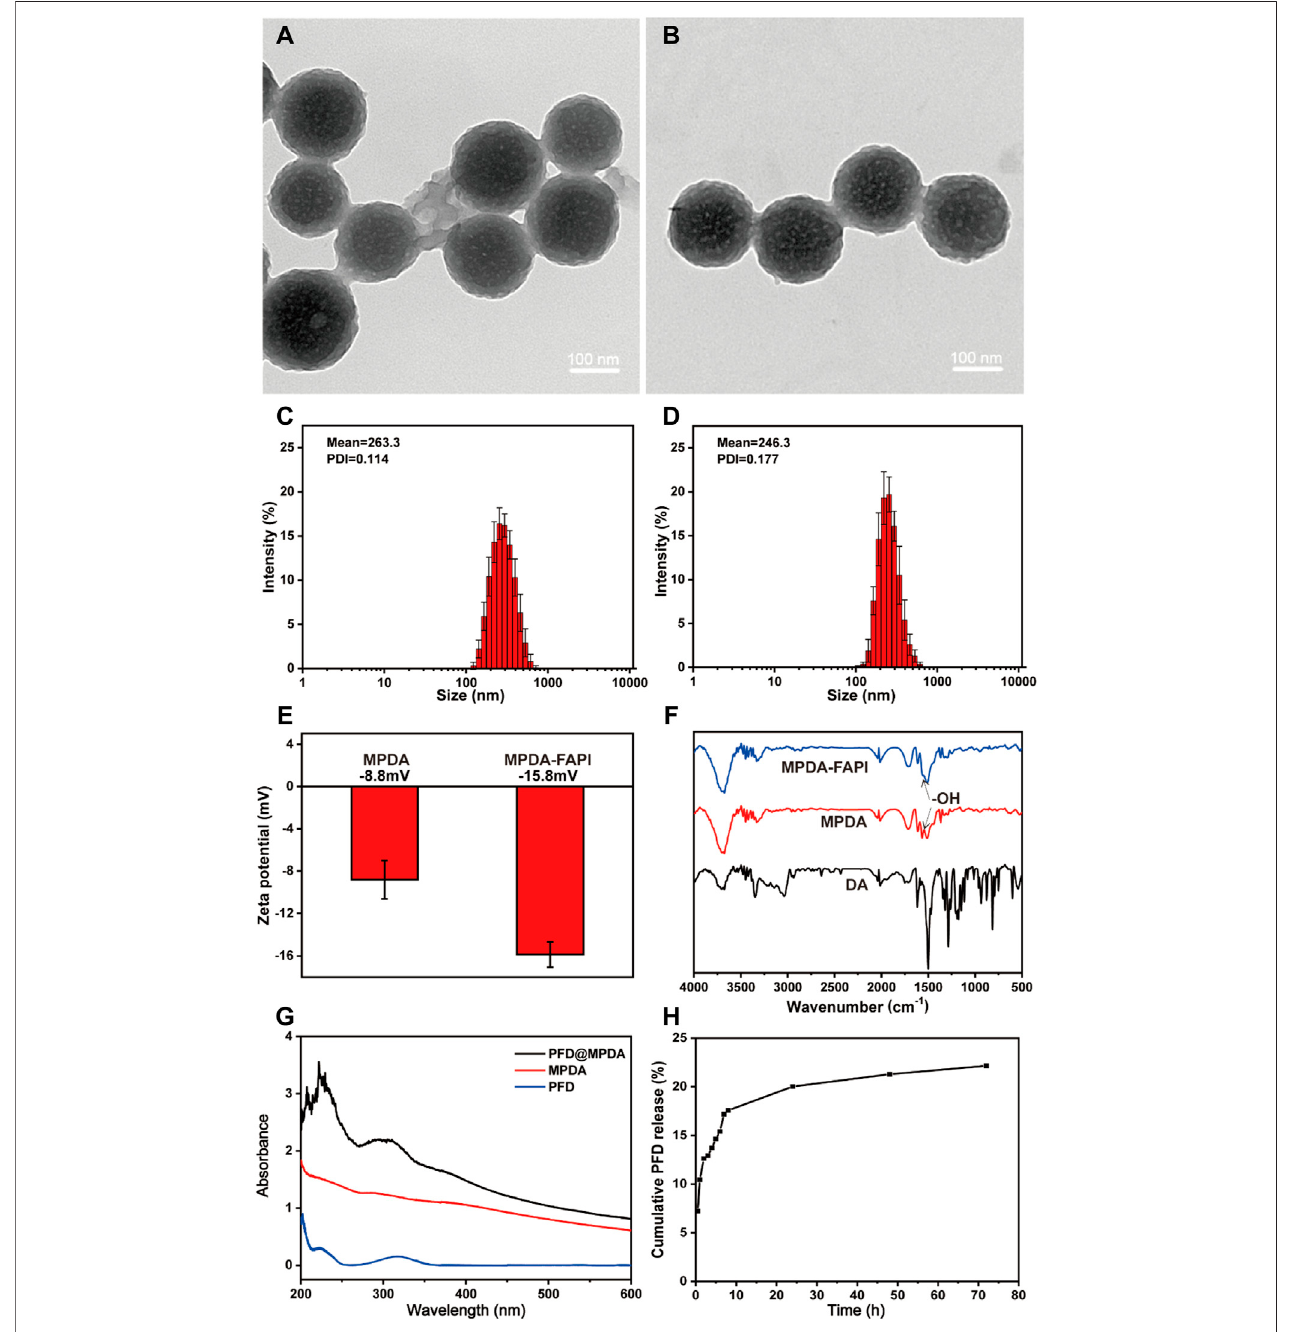
FIGURE 1 | TEM images of (A) MPDA and (B) MPDA-FAPI. Hydrodynamic diameters of (C) MPDA and (D) MPDA-FAPI. (E) Zeta potential of MPDA and MPDA- FAPI. (F) FTIR absorption spectrum of DA, MPDA, and MPDA-FAPI. (G) UV/Vis absorption spectrum of MPDA, PFD, and PFD@MPDA. (H) PFD released from PFD@ MPDA at pH 7.4 for 72